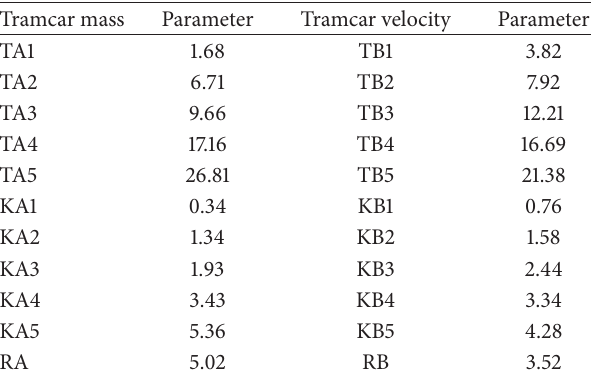
Table 5: Mass and velocity range analysis of tramcar.